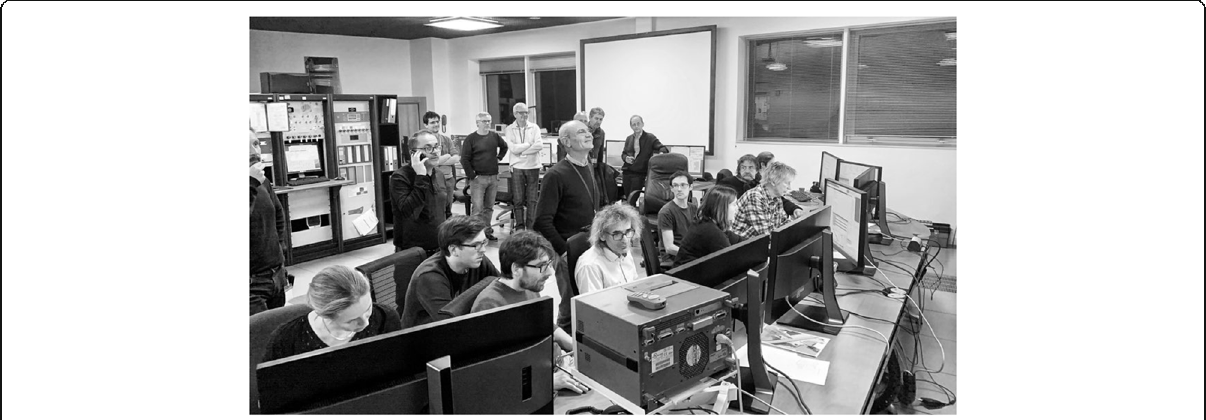
Fig. 14 Picture taken in the control room with Pantaleo Raimondi, Accelerator Division Director, and his team, checking the first stored beam